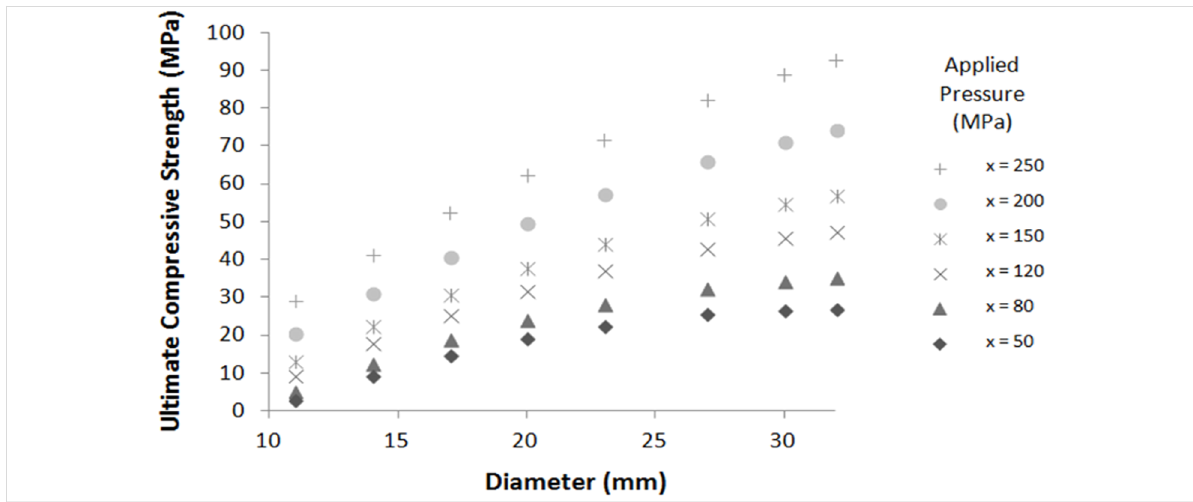
included in the studied range for predictive